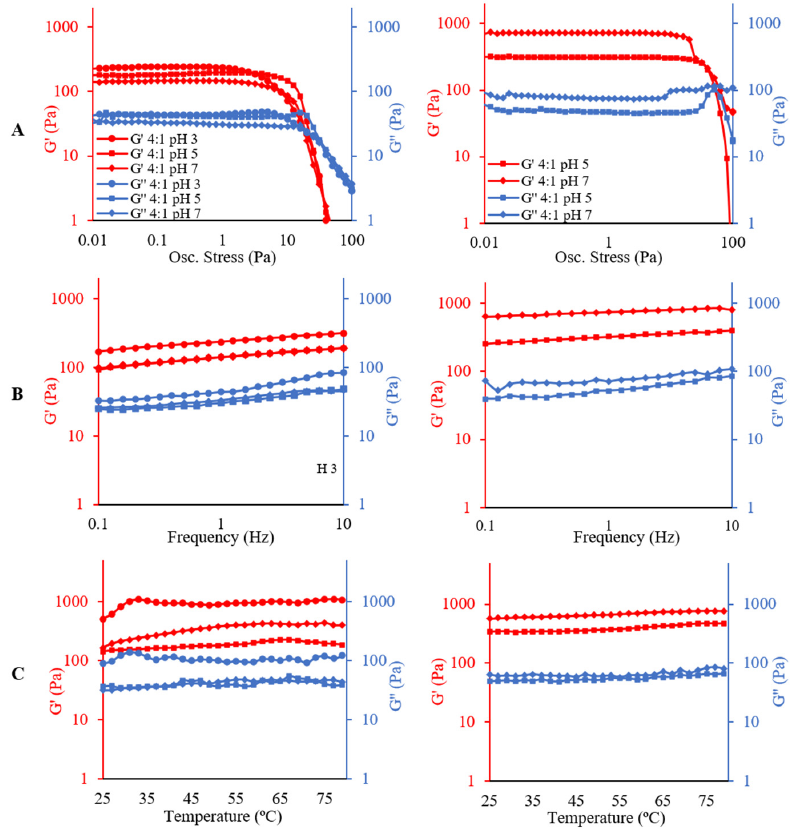
Figure 6. Amplitude ( A ), frequency ( B ) and temperature ( C ) curves of pea protein and xanthan gum-stabilized emulsions (left) and HIPEs (right).